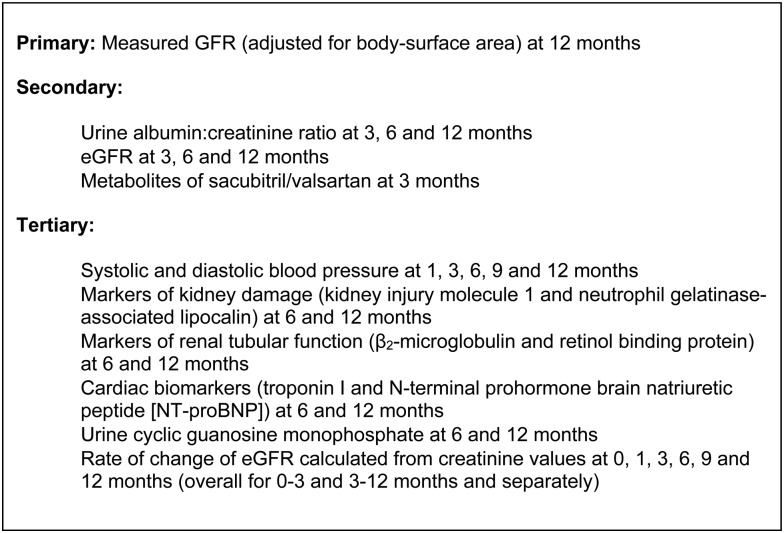
UK HARP-III trial outcomes.